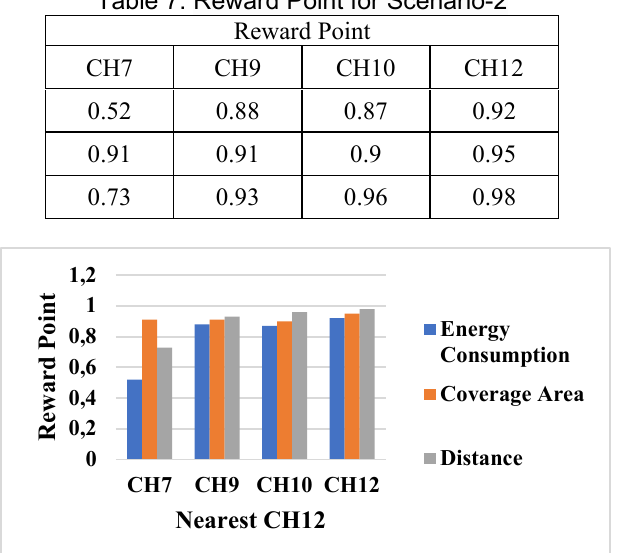
Figure 13. Reward point for Energy Consumption, Coverage Area, and Distance (Scenario-2)